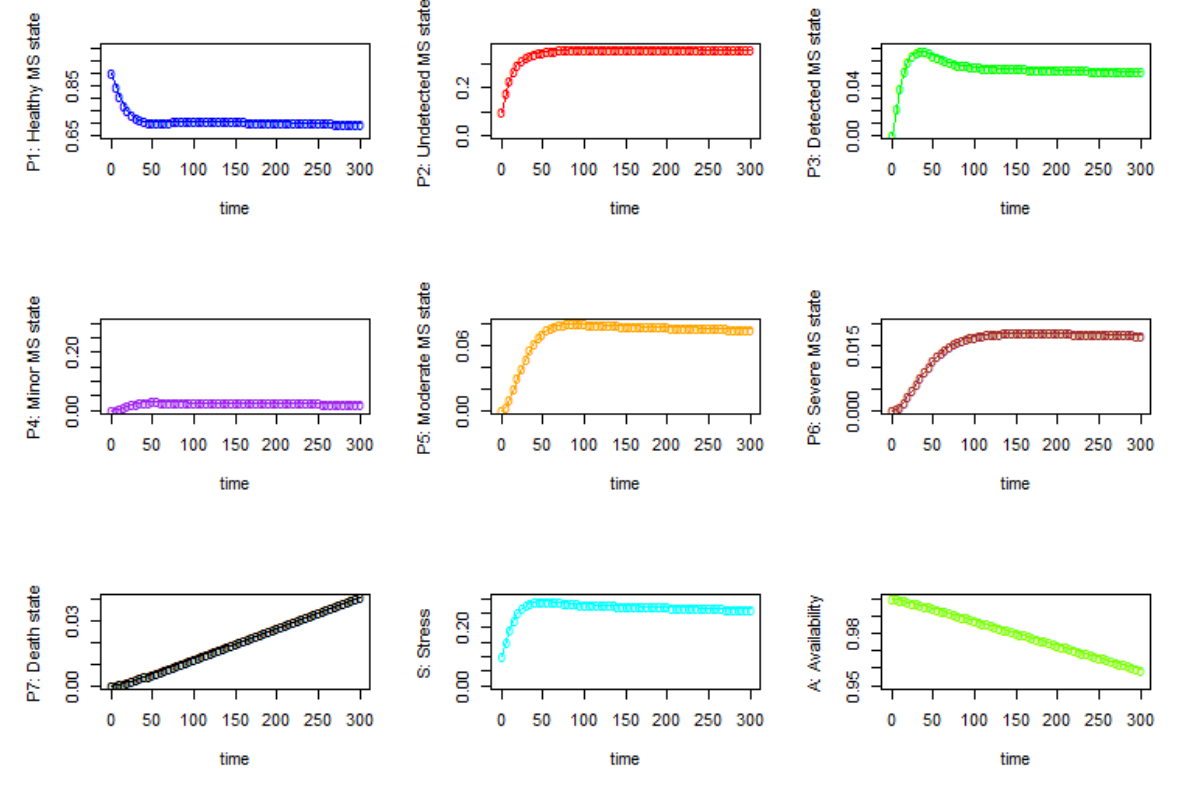
Figure 6. The probability results of each state for Case 3 (i.e., τ 1 = τ 2 = τ 3 = τ 4 = 0). Table 5. The correlation results of the system state for Case 3. and S 5 with − 0.91.